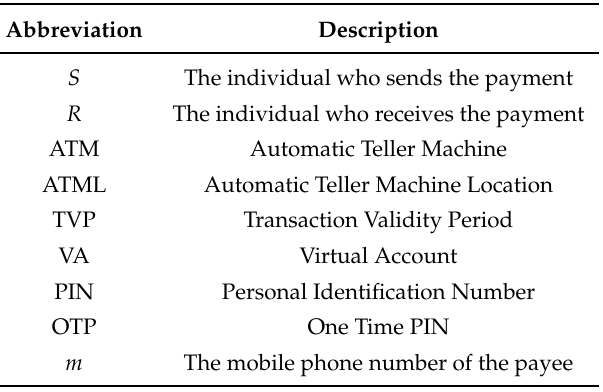
Figure 2. The transaction flow. Table 1. Abbreviation and